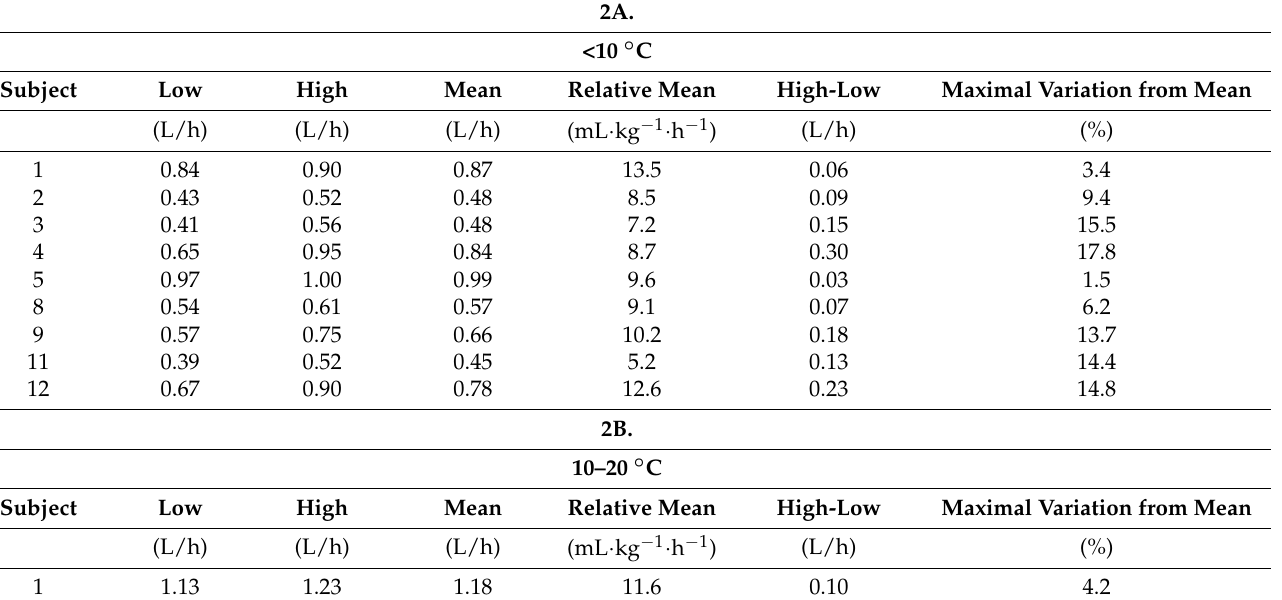
Table 2. Participant sweat rates (L/h) separated into highest, lowest, and mean values. 2A denotes Wet-Bulb Globe Thermometer values below 10 ◦ C, 2B values between 10–20 ◦ C, and 2C values above 20 ◦ C.